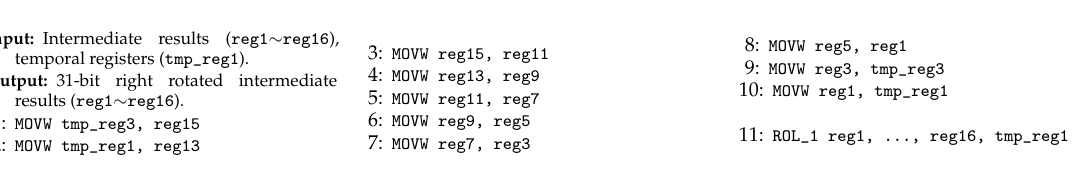
Algorithm 7 ROR_31 : 31-bit right rotation for 128-bit data.